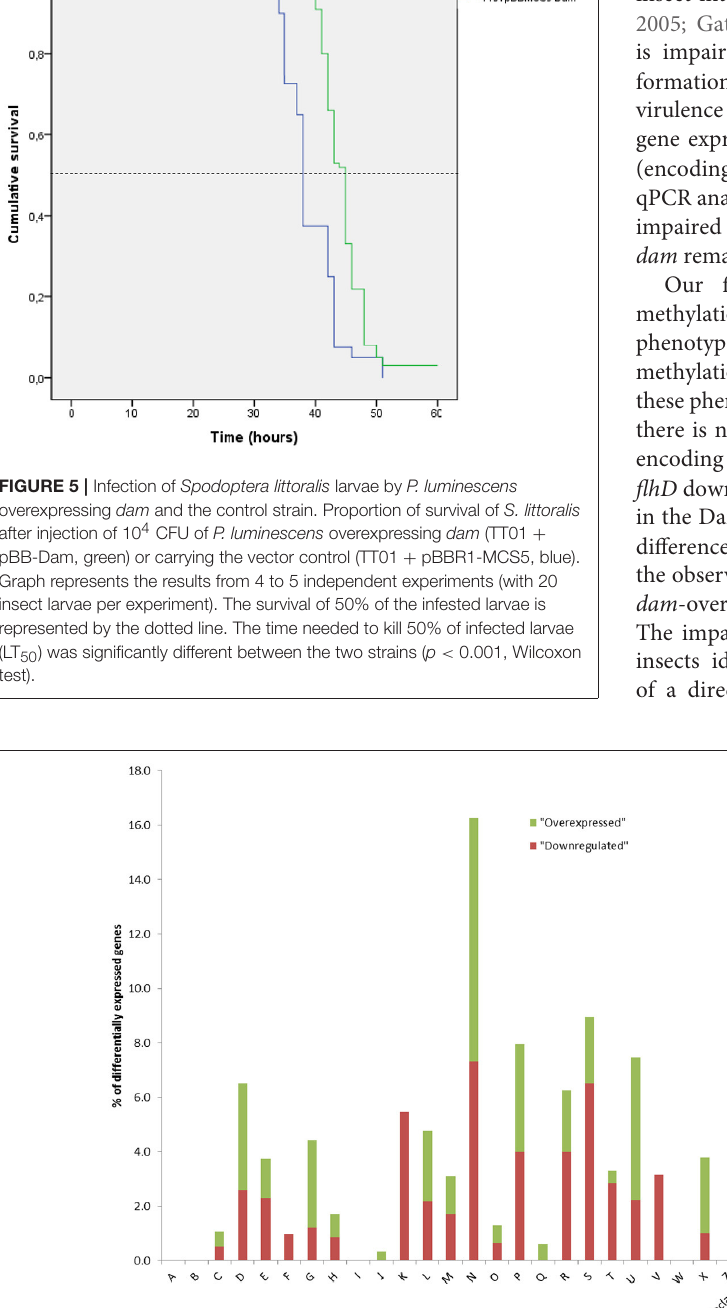
Frontiers in Microbiology |